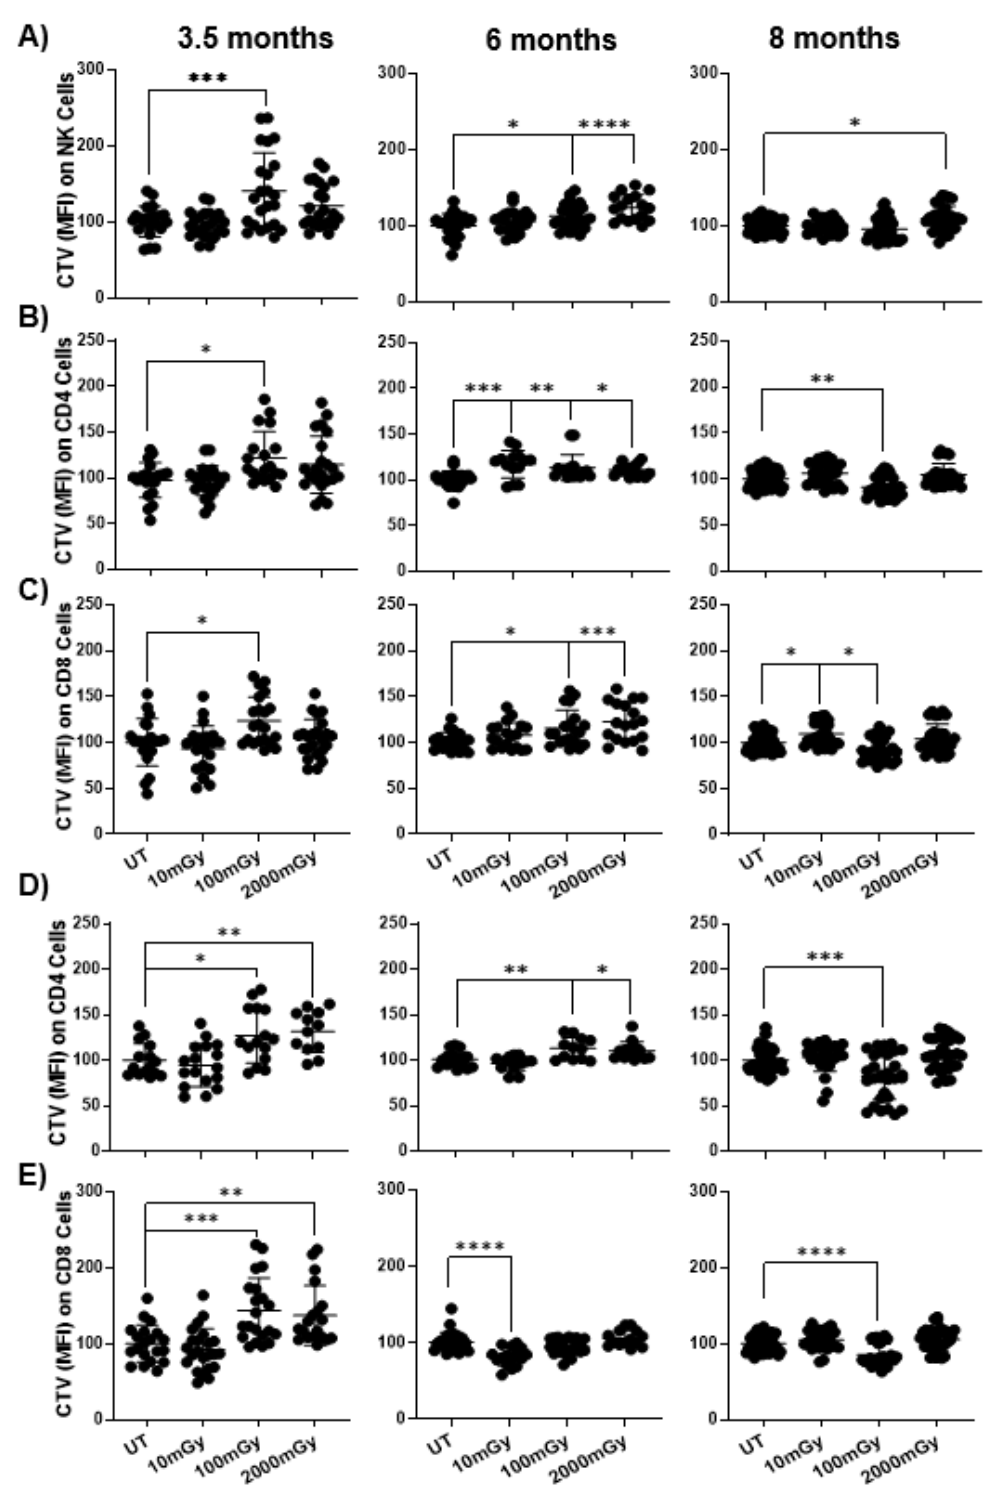
Figure 6. LDR suppresses immune cell proliferation. Single-cell suspensions were obtained from spleens of mice sacrificed at indicated time points after radiation exposure. Cells were stained with cell trace violet (CTV) dye and stimulated with ( A-C ) IL-2 (1000U/ml) or ( D-E ) anti-CD3/28 for three days. The MFI of CTV dye in NK, CD4+ and CD8+ cells was measured using flow cytometry. The experiment was performed in triplicate. Note, the higher intensity of the CTV dye indicates lower proliferation as the dye gets diluted upon cell division. Y-axis indicates the relative MFI percentiles among different treatment groups. MFI of untreated mice was set to 100%. Data represent mean + SD. * p < 0.05, ** p < 0.01, *** p < 0.001, **** p < 0.0001.